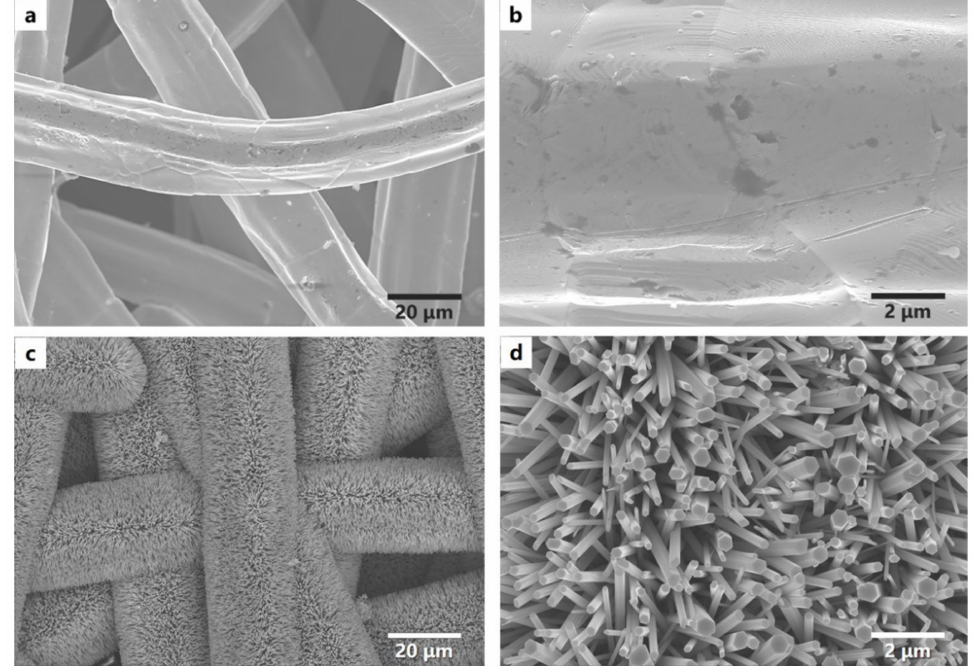
Figure 3. SEM images of original filter membrane ( a , b ). SEM images of ZnO-coated filter mem- brane ( c , d